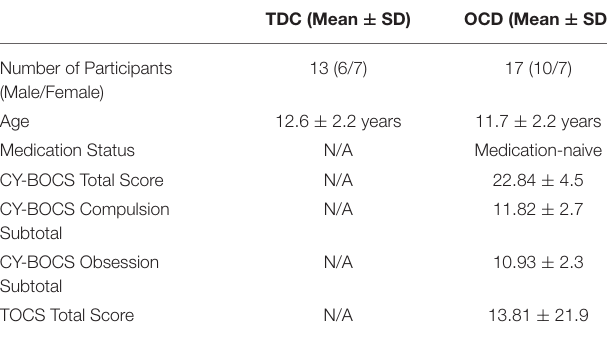
TABLE 1 | Overall sample demographic characteristics.